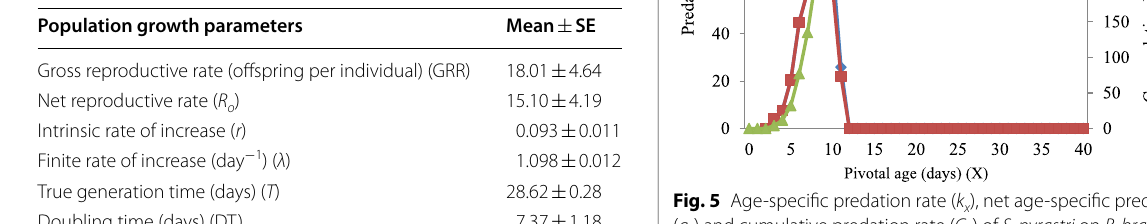
Table 2 Population growth parameters of S. pyrastri on cabbage aphid, B. brassicae